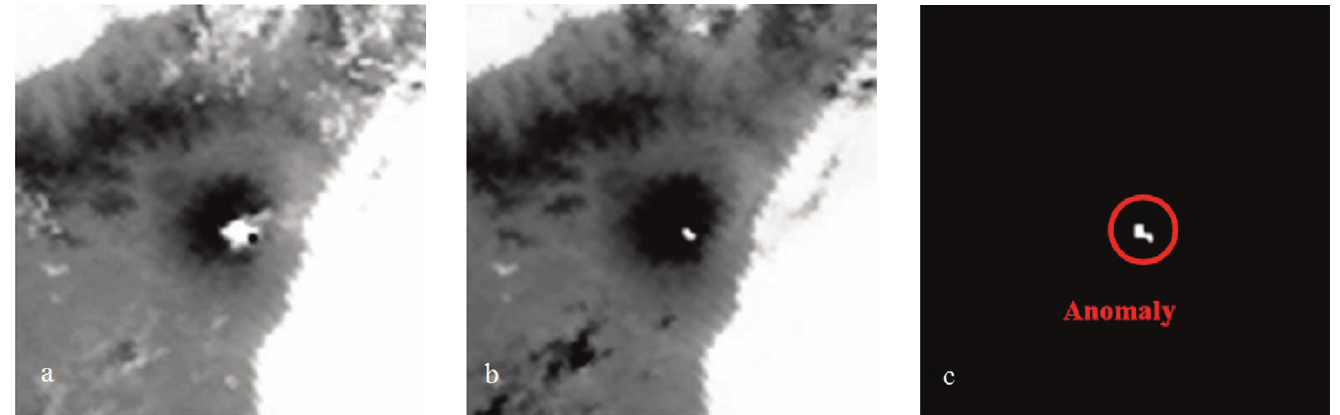
Figure 7. Mount Etna eruptive activity imaged by AVHRR during the 2006 eruption. (a) In MIR band 3. (b) In TIR band 4. (c) Hot-spot detection generated by AVHotRR.